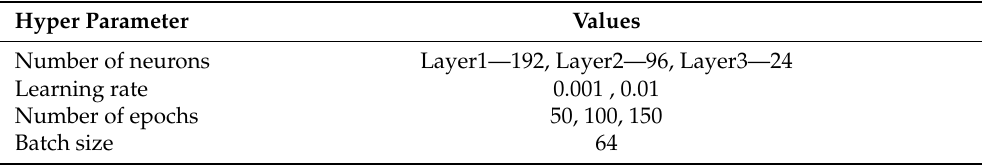
Table 2. Selection of hyper parameters for designing the NN